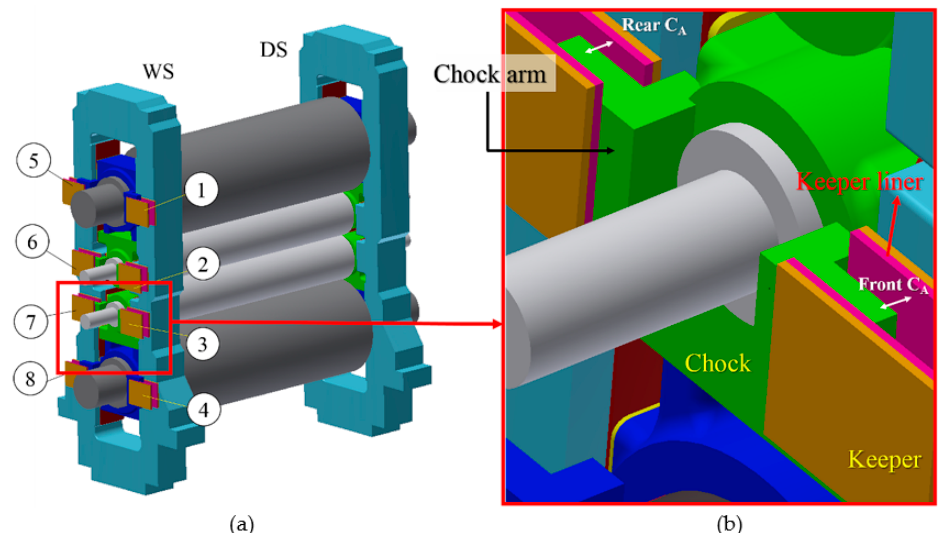
Figure 3. Schematic illustration showing axial clearances ( C A ). ( a ) Location of axial clearances, ( b ) axial clearances between chock arms and keepers.